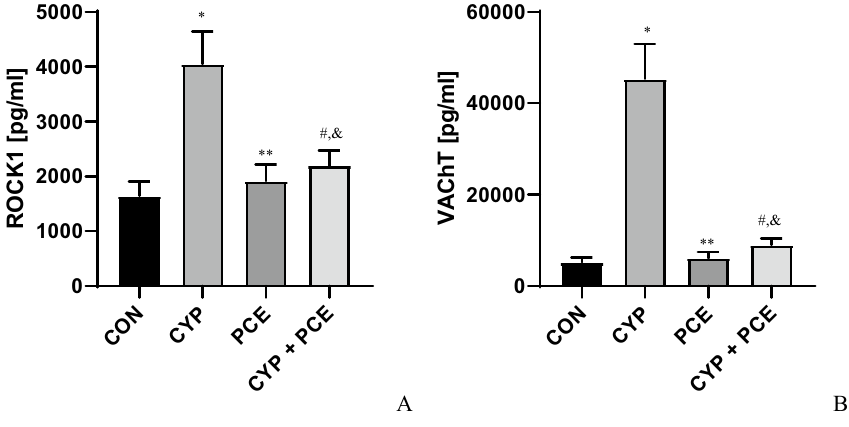
Figure 6. The influence of cyclophosphamide (CYP) and Potentilla chinensis aqueous extract (PCE) in naïve rats and PCE in rats with CYP-induced cystitis on the level of ( A ) ROCK1, and ( B ) VAChT in detrusor